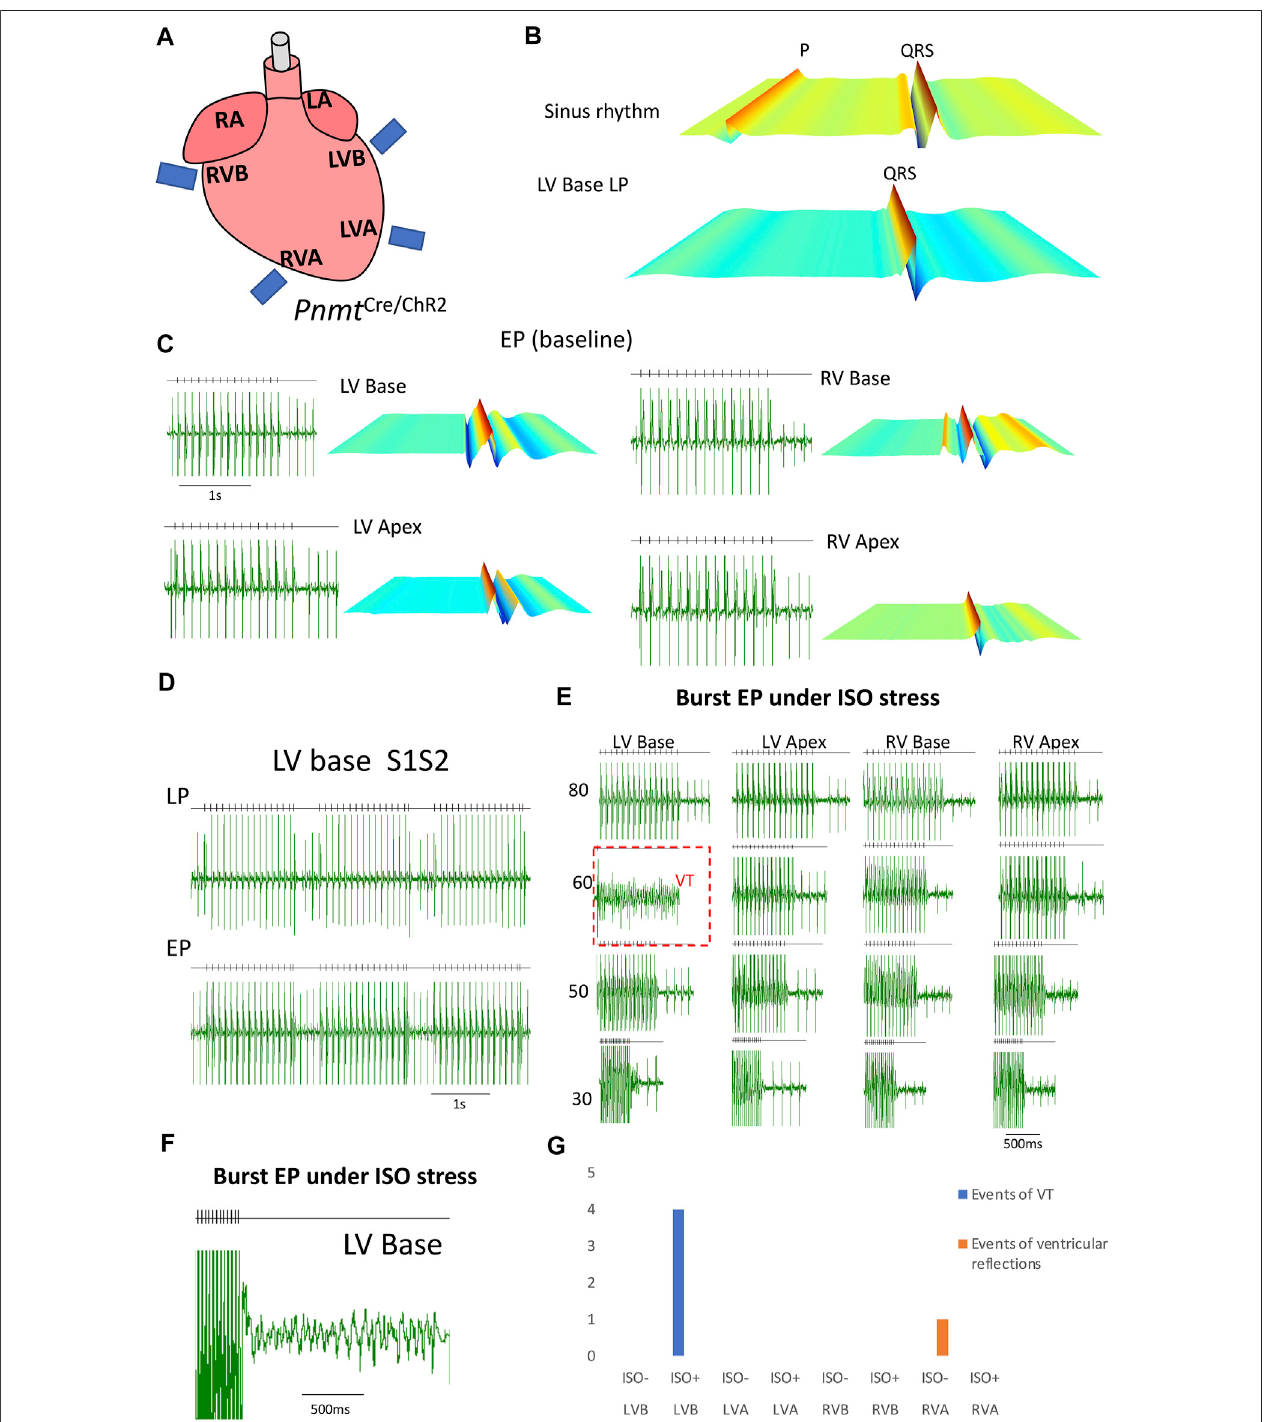
FIGURE6| Controllingheartrhythm withselectiveoptogenetic stimulation and electrical pacingunder β -adrenergic stressconditions inducedbyadministration of isoprenaline (ISO) compared with a baseline condition in an adult Pnmt Cre/ChR2m mouse model. (A) . Localized lightpacing and electrical pacing in different regions of the heart. (B) . The upper panel shows a representative ECG recording of a Pnmt Cre/ChR2 heart in intrinsic sinus rhythm. The bottom panels show representative ECG recordings of this heart paced by targeting blue light pulses to LV base regions respectively. “ P ” in representative ECG recordings stands for “ P wave ” . (C) . Examples of ECG recordings in the four different regions of Pnmt Cre/ChR2 mouse hearts under baseline conditions. (D) . ECG was recorded in the LV base of a Pnmt Cre/ChR2 heartbyprogrammedlightstimulation(PLS)andelectricalpacingwiththeS1S2protocol. (E) .ECGofPnmt Cre/ChR2